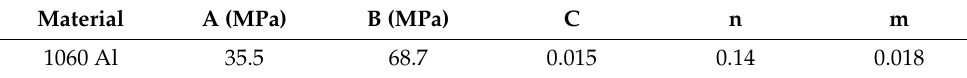
Table 4. Parameters of Johnson–Cook model for Al